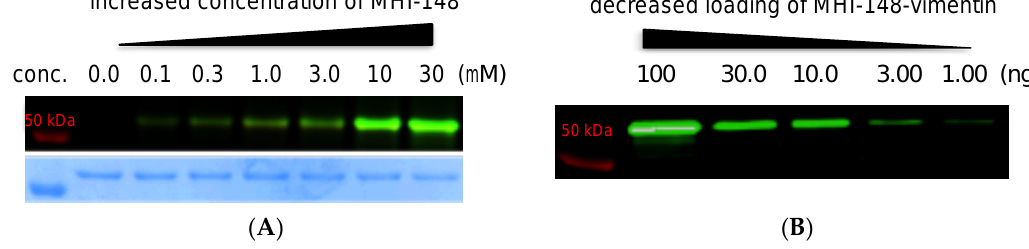
Figure 5. NIR fluorescent gel image of ( A ) vimentin (1 µM) incubated with different concentrations of MHI-148 in 50 mM pH 7.24 HEPES buffer for 3 h at 37 °C ( B ) 10:1 concentration ratio of MHI-148:vimentin sample was loaded into 10% SDS-PAGE gel with different amounts of vimentin sample.